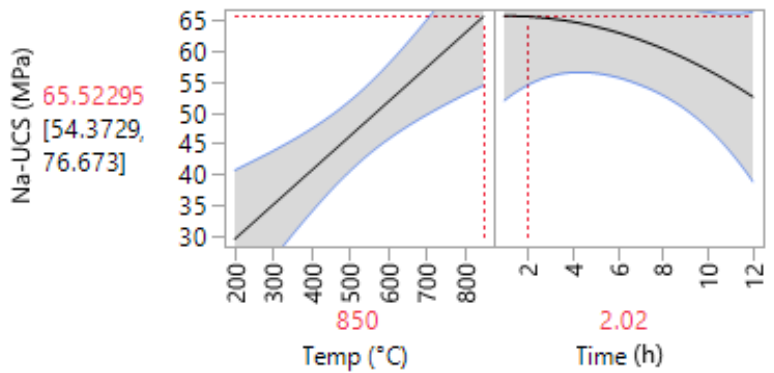
Figure 7. Prediction profiler for Na-based geopolymer cement.